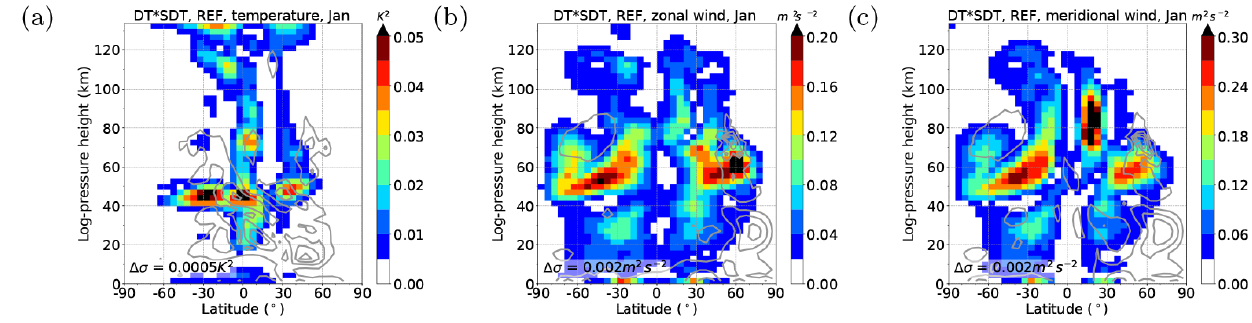
Figure 4. Product of DT and SDT amplitudes, scaled by exp {− z( 2 H) − 1 } for temperature (a) , zonal wind (b) and meridional wind (c) ; January conditions. Results are an average of the 11 ensemble members (color shading). Standard deviations ( σ ) are added as gray contour lines.